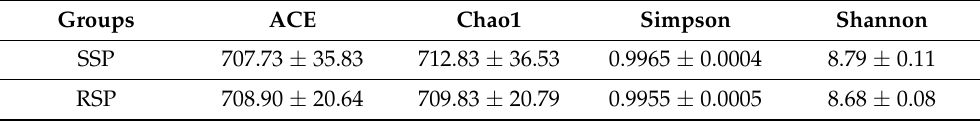
Table 2. Bacterial diversity indices in different groups. Table 3. Fungal diversity indices in different groups. Groups ACE Chao1